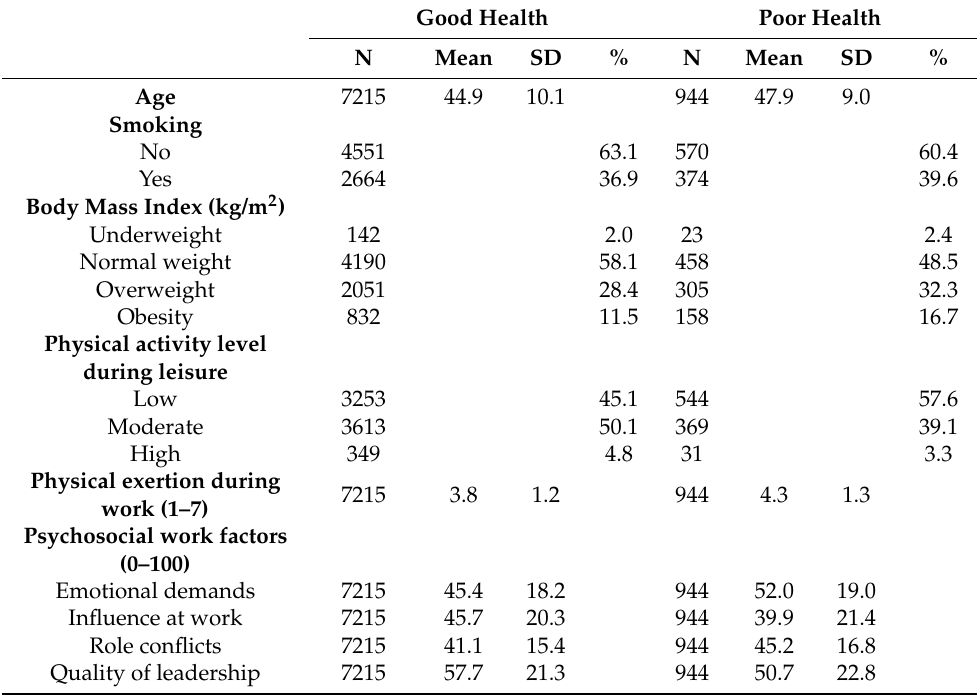
Table 2. Participants baseline characteristics and lifestyle